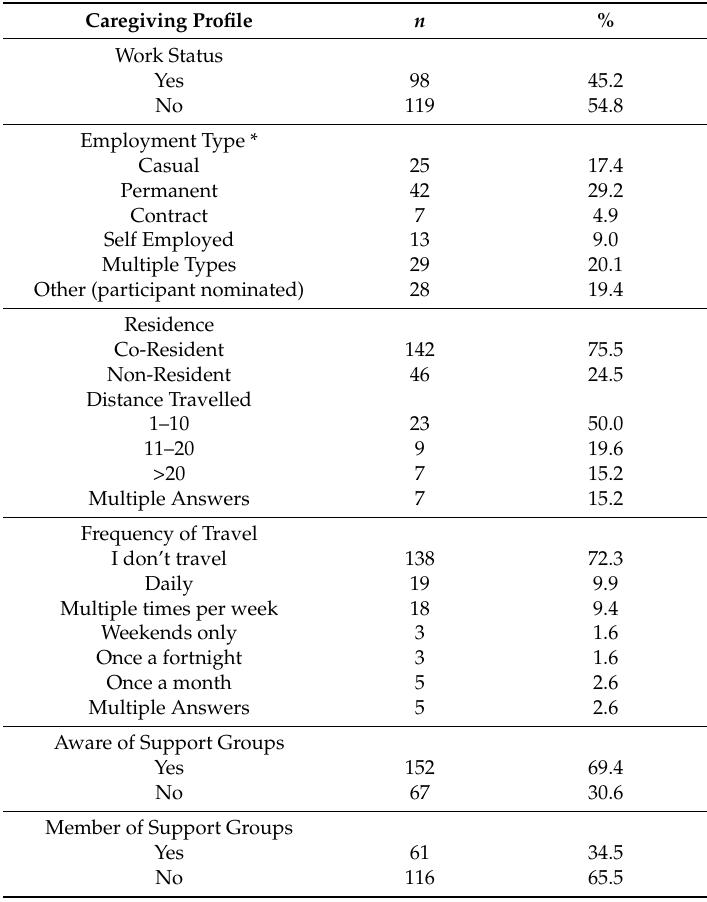
Table 2. Caregiving profile of study